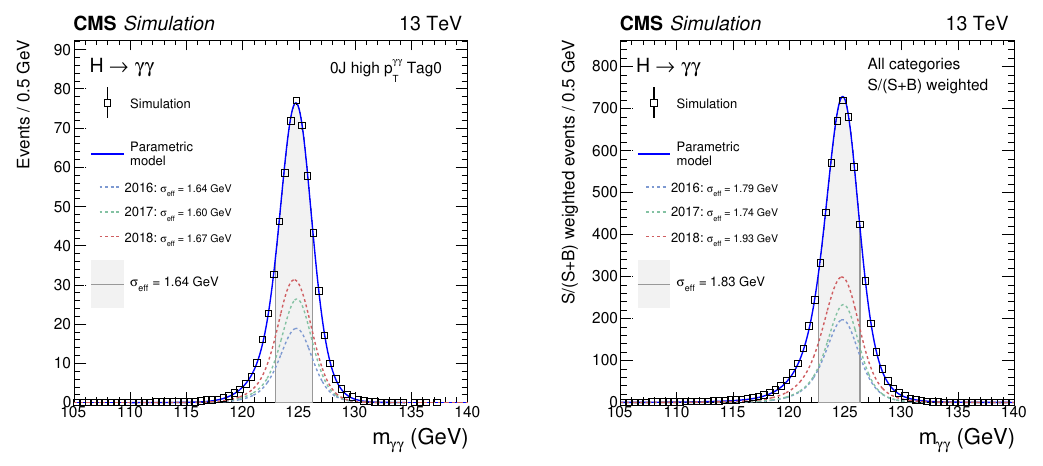
Figure 12 . The shape of the parametric signal model for each year of simulated data, and for the sum of all years together, is shown. The open squares represent weighted simulation events and the blue line the corresponding model. Also shown is the σ value (half the width of the narrowest eff interval containing 68.3% of the m distribution) in the grey shaded area. The contribution of gg the signal model from each year of data taking is illustrated with the dotted lines. The models are shown for an analysis category targeting ggH 0J high p H production (left), and for the weighted T sum of all analysis categories (right). Here each analysis category is weighted by S/(S+B), where S and B are the numbers of expected signal and background events, respectively, in a ± 1 σ m eff gg window centred on m H